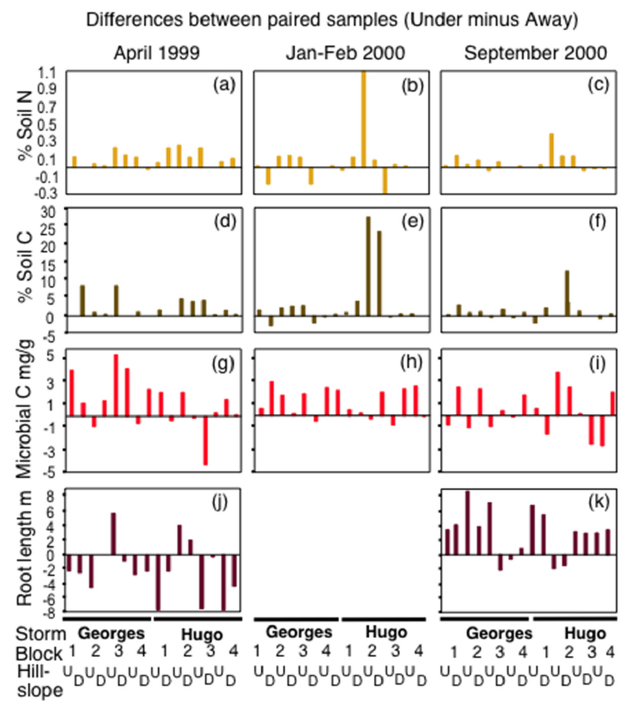
Figure 5. Percent soil N and C, microbial biomass C, and total root length are presented as differences in values between paired (8 × 8) cm soil cores taken to 10 cm depth under decomposing logs minus values for samples taken 20–50 cm away and not under the logs. Thus, bars above the zero line had greater values under than away from the log within a pair while bars below the line had lower values under than away from the log. Bars represent a single pair of samples, one pair taken in the upslope direction (Hillslope U) and the other pair taken in the downslope direction (Hillslope D) on the same day. Logs fell in either Hurricane Hugo (1989) or Hurricane Georges (1998). Two logs, one from each hurricane, were represented in each of the four blocks. April 1999 sampling was during the dry season, 0.6 and 9.5 years after Hurricane Georges and Hugo, respectively. January 2000 was the end of the wet season, 1.4 and 10.4 years after Hurricanes Georges and Hugo, respectively. September 2000 was during the wet season 2 and 11 years after Hurricanes Georges and Hugo, respectively. ( a – c ) Difference (under—away) in soil % N; ( d – f ) Difference (under—away) in soil % C; ( g – i ) Difference (under—away) in microbial biomass C; ( j , k ): Difference (under—away) in m total root